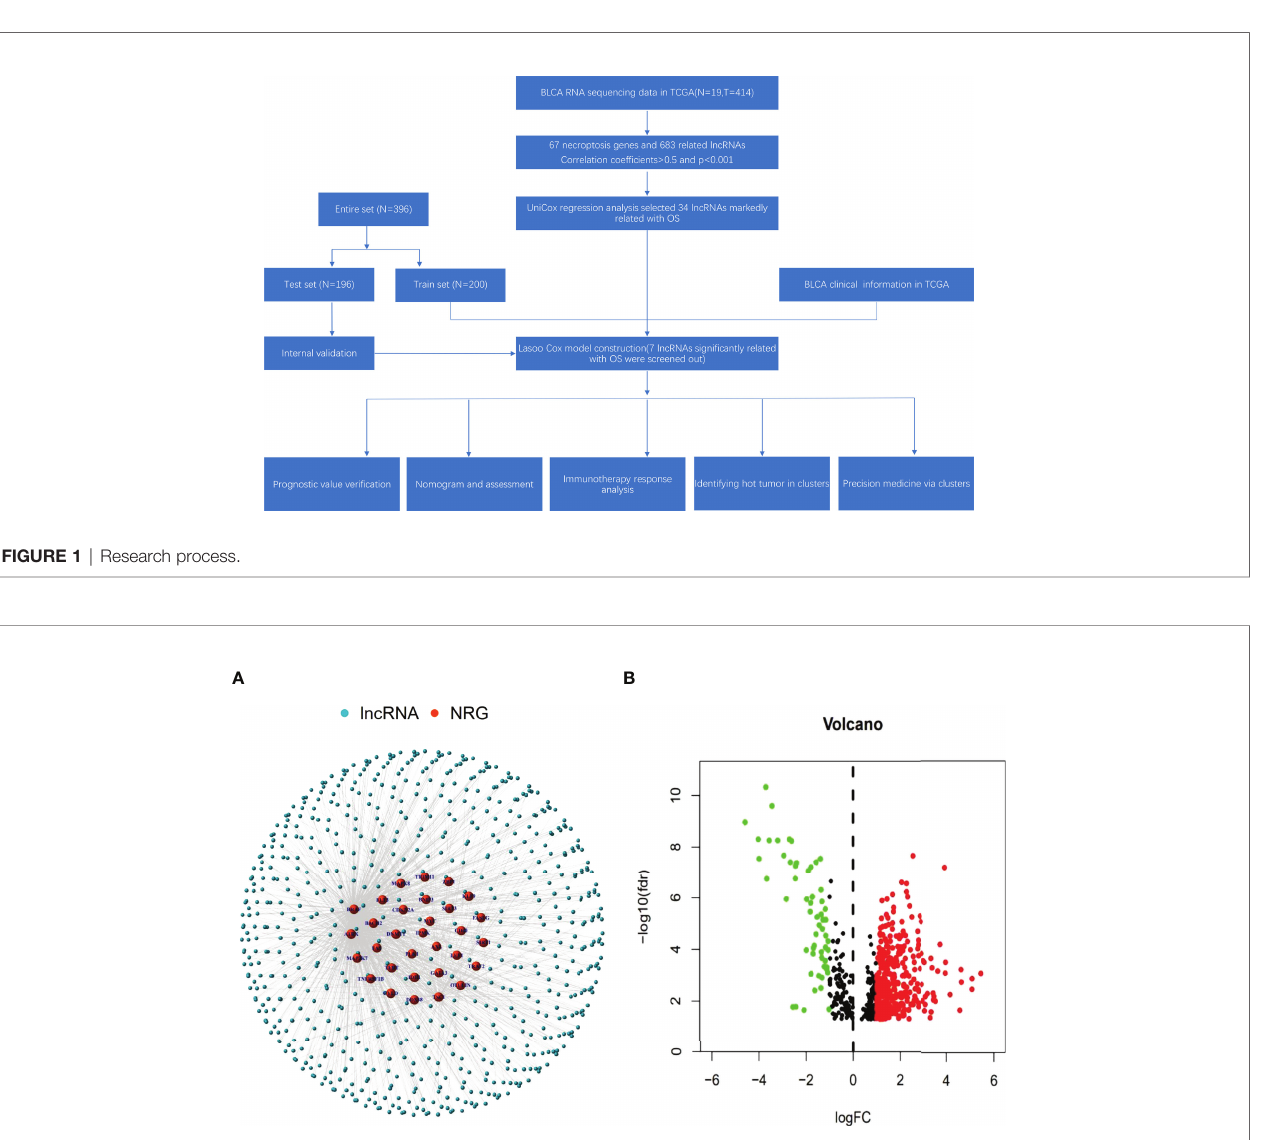
FIGURE 2 | Identi fi cation of necroptosis-associated lncRNAs in BLCA patients. The co-expressed relationship between necroptosis genes (NRG) and lncRNAs (correlation coef fi cients>0.5 and p < 0.001) (A) . The volcano plot of 439 necroptosis-associated lncRNAs with differential expression (|Log2FC|>1, p < 0.05) (B) .